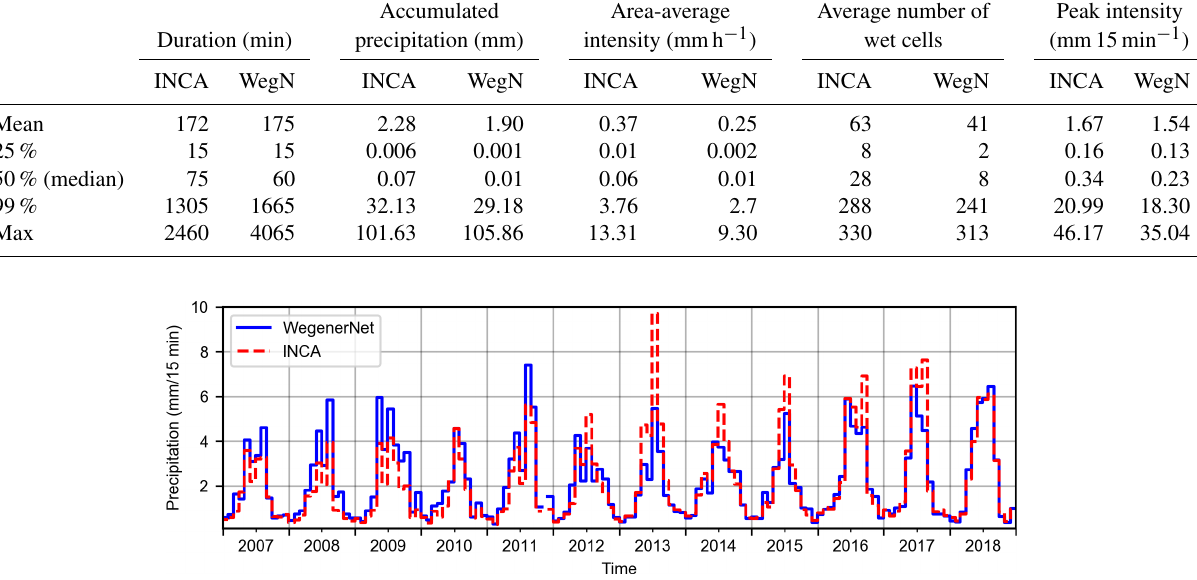
end later in INCA by an average of 24 min, and 20 % end ear- lier by an average of 26 min. Note that starting/ending time is considered within 15 min since the temporal resolution is 15